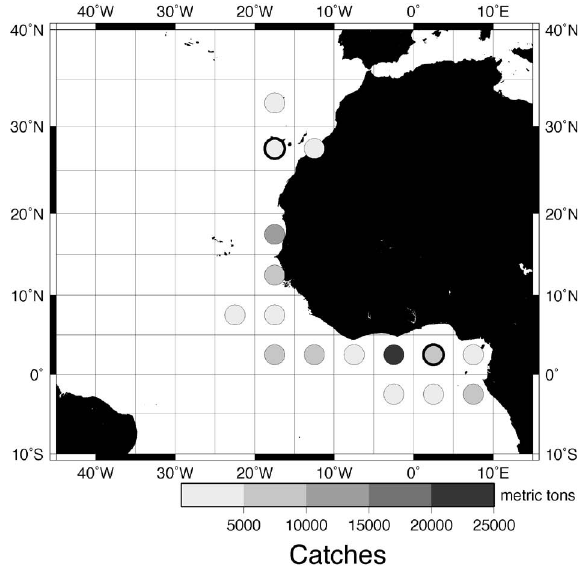
Fig . 1. – Location of the study area. The grey scale indicates the av- erage annual catch of each area in metric tons. The two areas chosen for capture data reconstruction (Canary Islands and Gulf of Guinea) were black